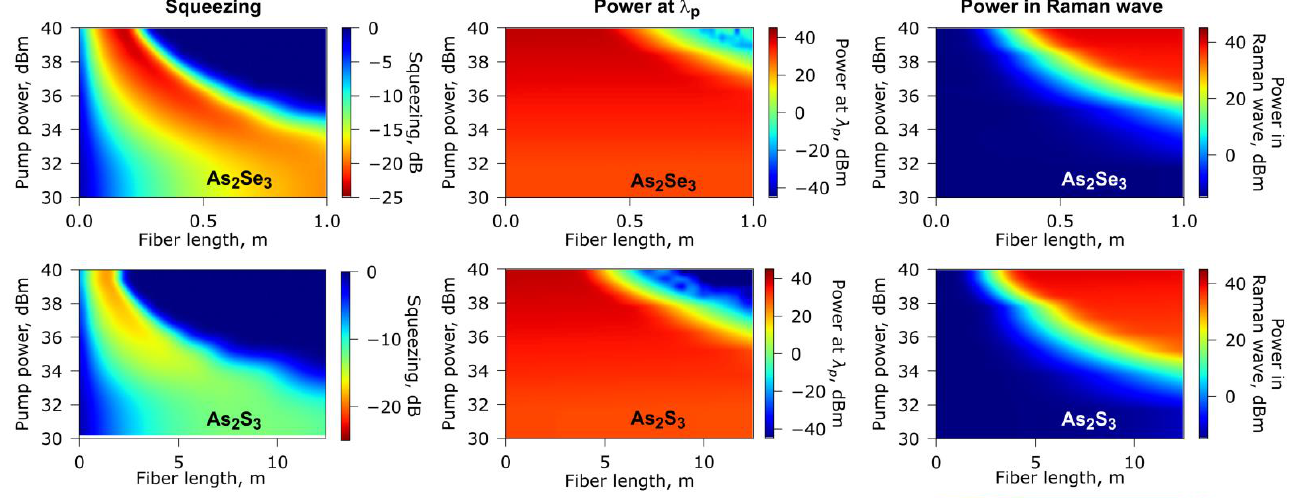
Figure 3. Numerically simulated quantum noise squeezing ( left columns ), power at the pump wavelength ( middle column ), and power in Raman wave ( right column ) as a function of both fiber length and pump power for fibers made of different glasses. 4. Discussion In the presented work, we have proposed the generation of multiphoton states of 10-W class light in the 2-micron wavelength range with squeezed quantum fluctuations stronger than − 15 dB in chalcogenide and tellurite soft glass fibers with large Kerr non- linearities. Using a realistic step-index customized design and commercial fibers with nonlinear Kerr coefficients that are 2 – 4 orders of magnitude larger compared to standard silica fibers, we have numerically studied the possibility of quantum noise squeezing in the framework of the stochastic nonlinear Raman-modified Schrödinger equation by taking into account Kerr nonlinearity, distributed losses, and inelastic light scattering processes. We have theoretically revealed the factors limiting noise suppression. At rela- tively high pump powers (>36 dBm) and lengths longer than optimal ones, the deter- ministic Raman nonlinearity plays a significant role in soft glass fibers. For relatively low pump powers (<33 dBm), the deterministic Raman nonlinearity is not very important; the main limiting factor is optical loss. Quantum noise squeezing stronger than − 20 dB is numerically predicted for a customized As 2 Se 3 fiber for optimal fiber lengths shorter than 1 m. For commercial As 2 S 3 and customized tellurite glass fibers, a squeezing in the − 20 –− 15 dB range can be expected to be reached for fiber lengths of the order of 1 m. We verified that silica fibers are not suitable for strong noise suppression at the 2 µm wave-